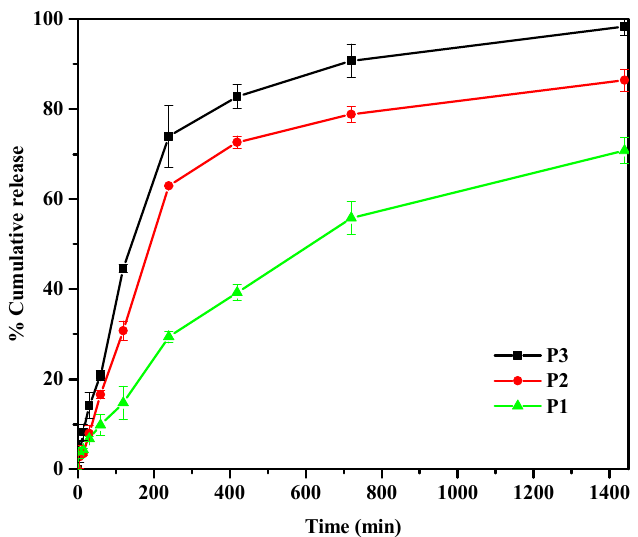
Figure 7. In vitro release behavior of 5-FU through PPK hydrogels in pH 7.4 at 37 °C for P1, P2, and P3.